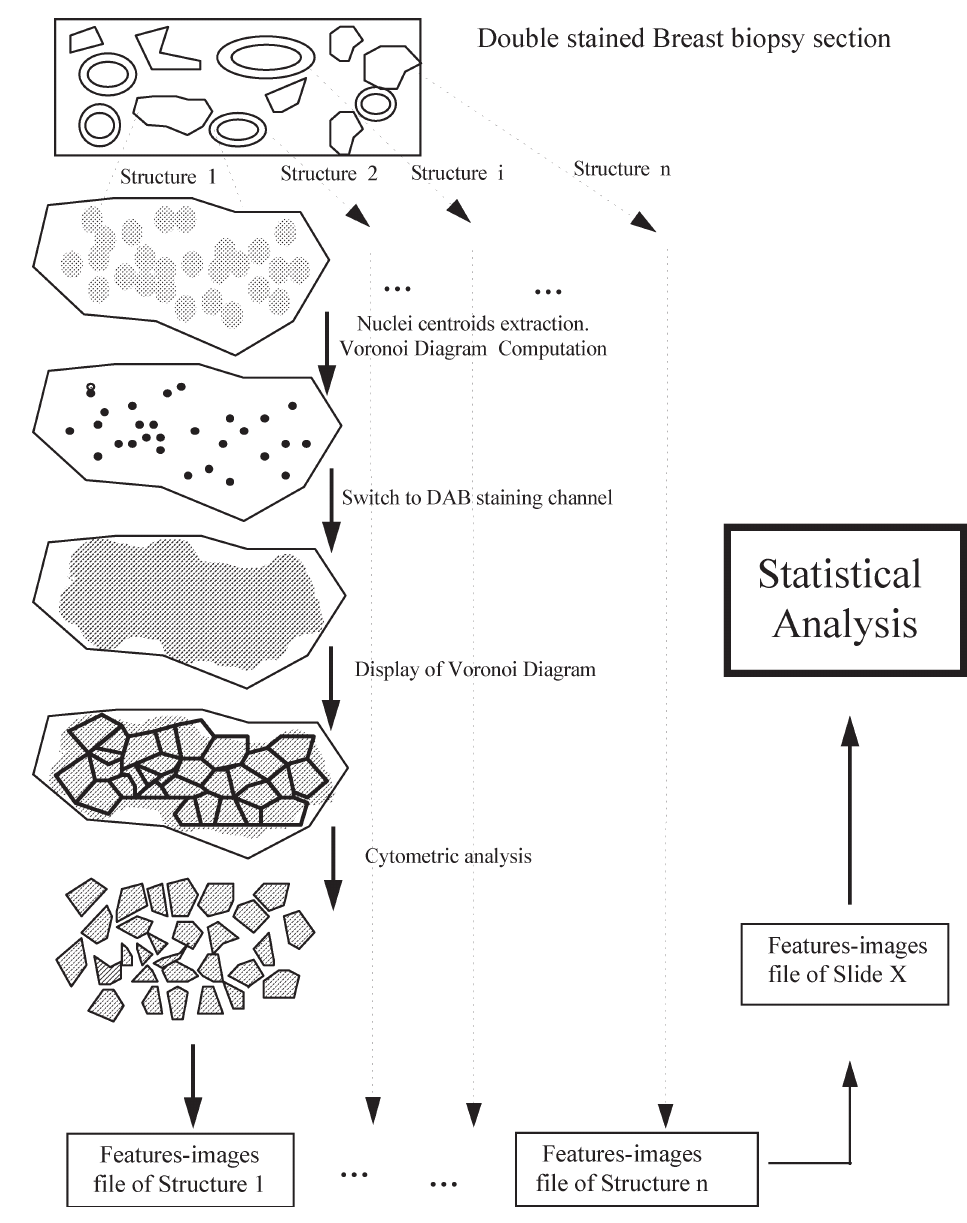
Fig. 3. A schematic illustration of the use of the VORSTAIN program. Several different structures may be identified on each slide, and grouped according to their histological type and position on the slide. For each structure, an image of the nuclear stain is acquired and used to identify the position of nuclear centroids within the ROI. An image of the immunohistochemical label is acquired and construction of the Voronoi diagram proceeds according to methods outlined in the text. Cytometric feature analysis is performed for each Voronoi polygon within the region and image/mask pairs and feature data are stored within a file, and analysis of another region of interest may begin. Statistical analysis of the features/images file may be performed at a later